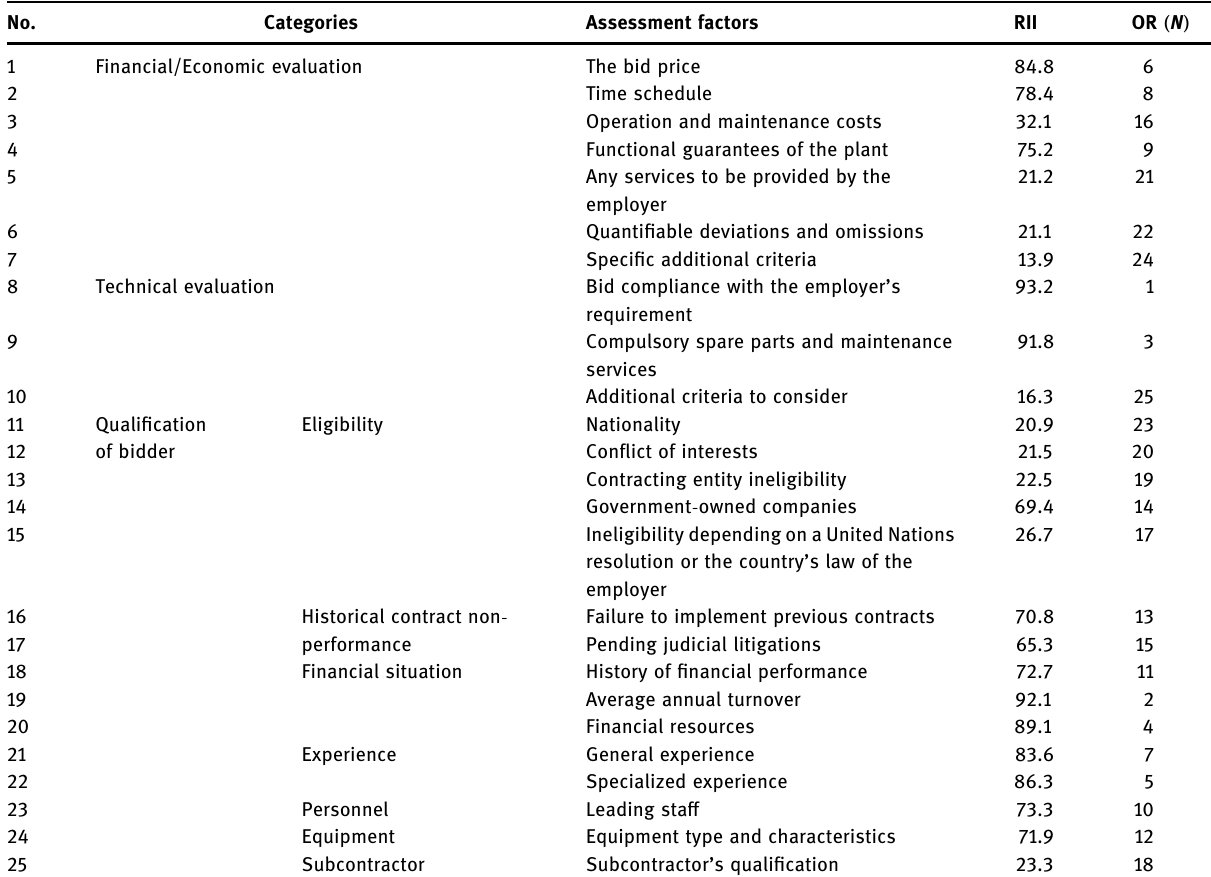
Table 6: Criteria ( factors ) arranged according to the signi fi cance